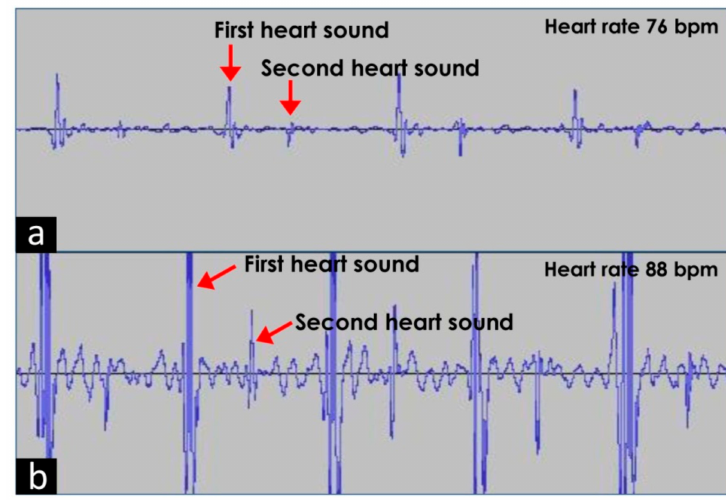
Figure 5. Waveform obtained from Audacity ® showing recorded heart sound of ( a ) an adult male and an ( b ) adult female. bpm: Beats per